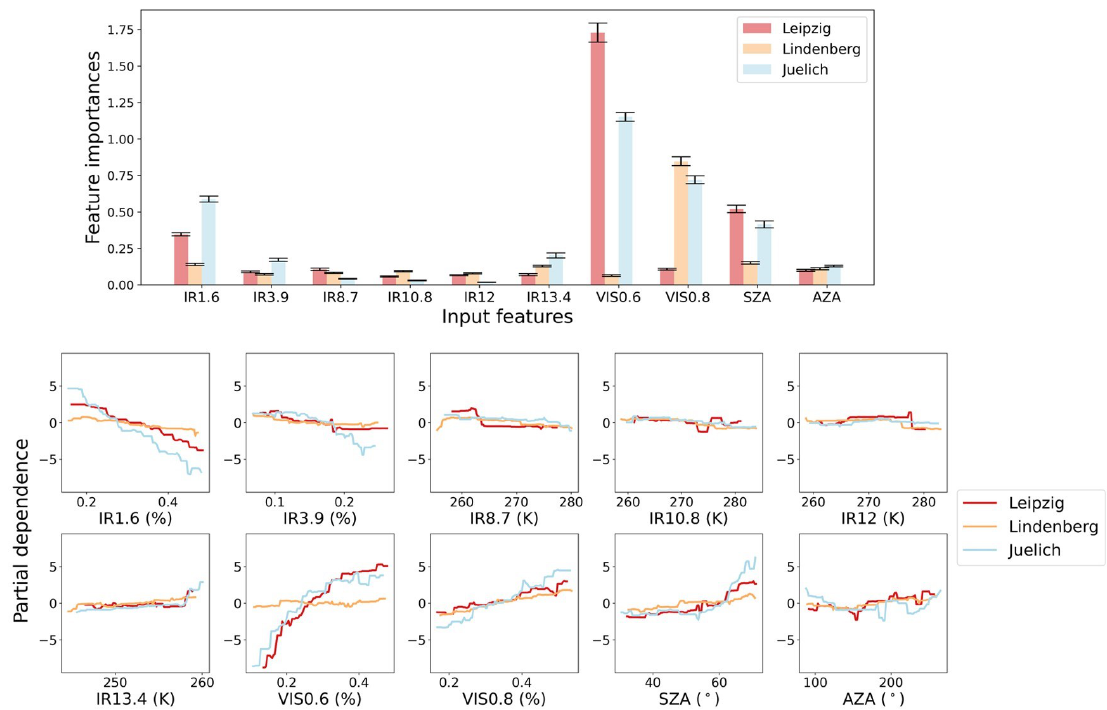
Figure 7. Feature importance ( top ) and partial dependence plot ( bottom ) for training data for homogeneous cloud fields without feature selection. The y -axis of the partial dependence plot shows the changes of LWP (in units of LWP) relative to the mean prediction (centered around zero) for each grid value on the x